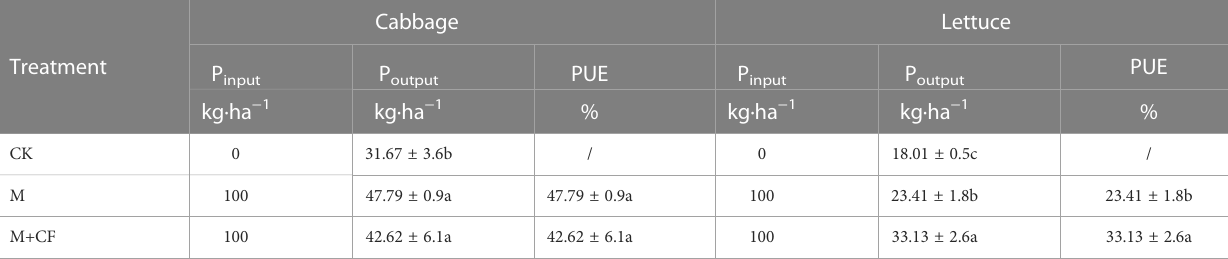
TABLE 3 Mean annual P output and PUE of two vegetables among three